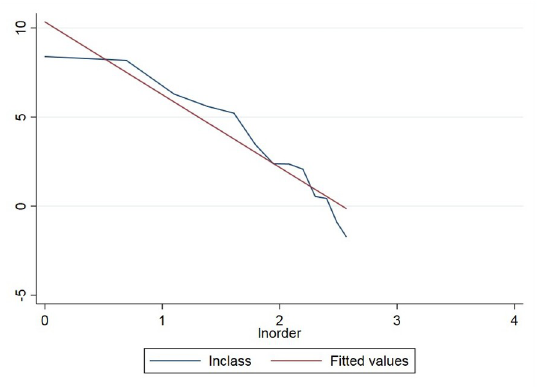
Fig 9. The double logarithmic distribution curve of class numbers for RSE in China from 2003–2014.